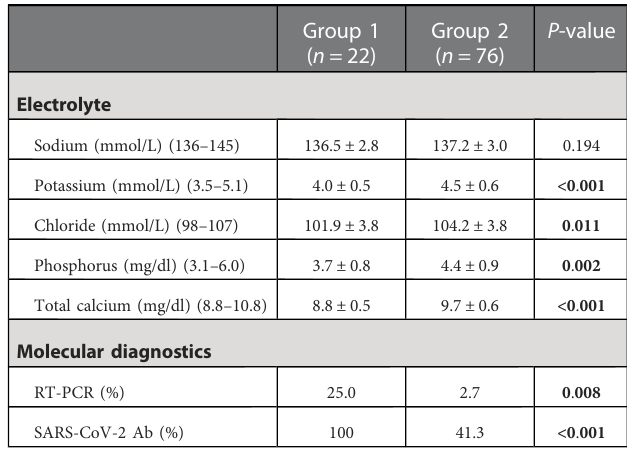
sedimentation rate; PT, p rothrombin time; aPTT, activated partial thromboplastin time; AST, aspartate aminotransferase; ALT, alanine aminotransferase; BUN,